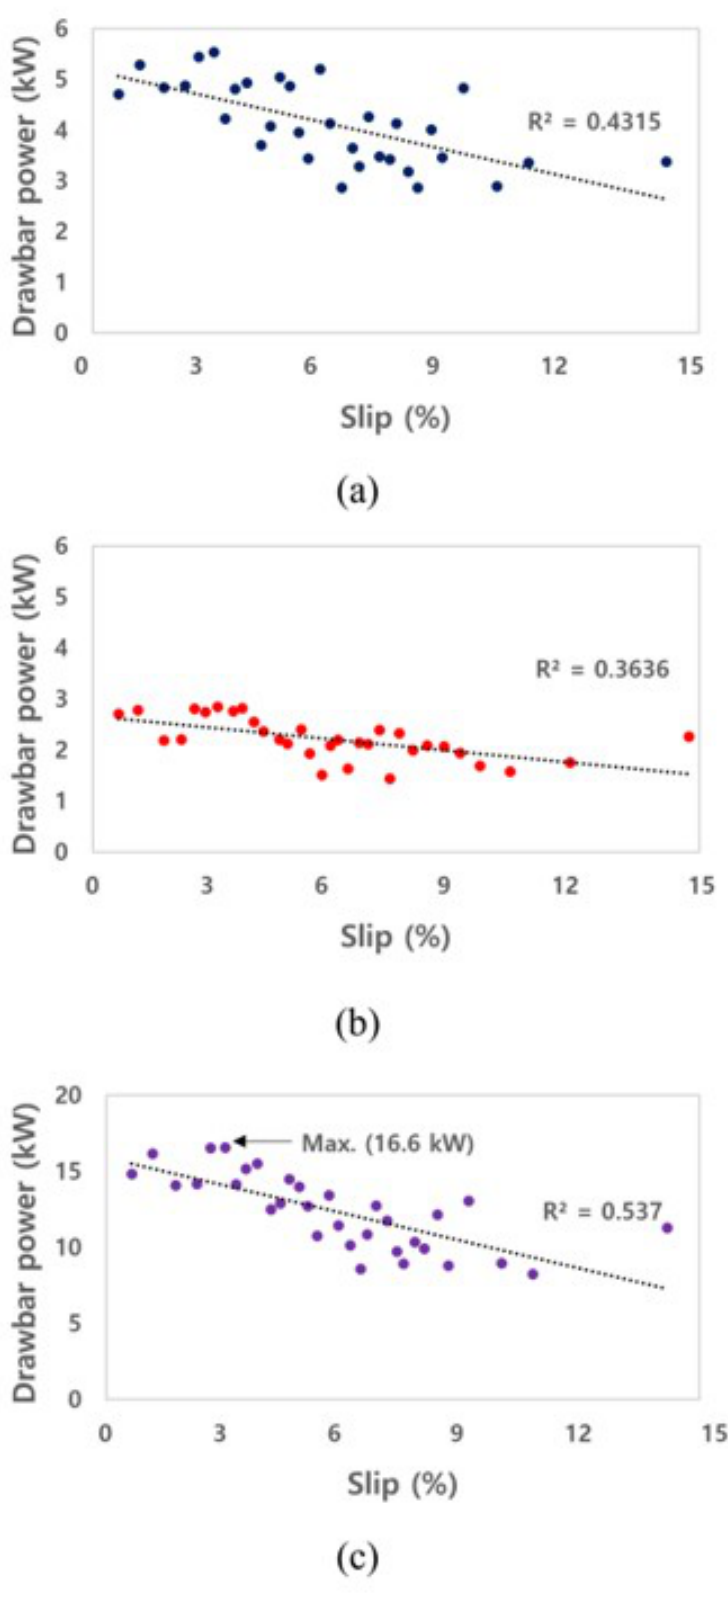
Figure 8. Results of drawbar power as slip for the electric AWD tractor during traction test: ( a ) a left axle, ( b ) a right axle, and ( c ) sum of all axles.